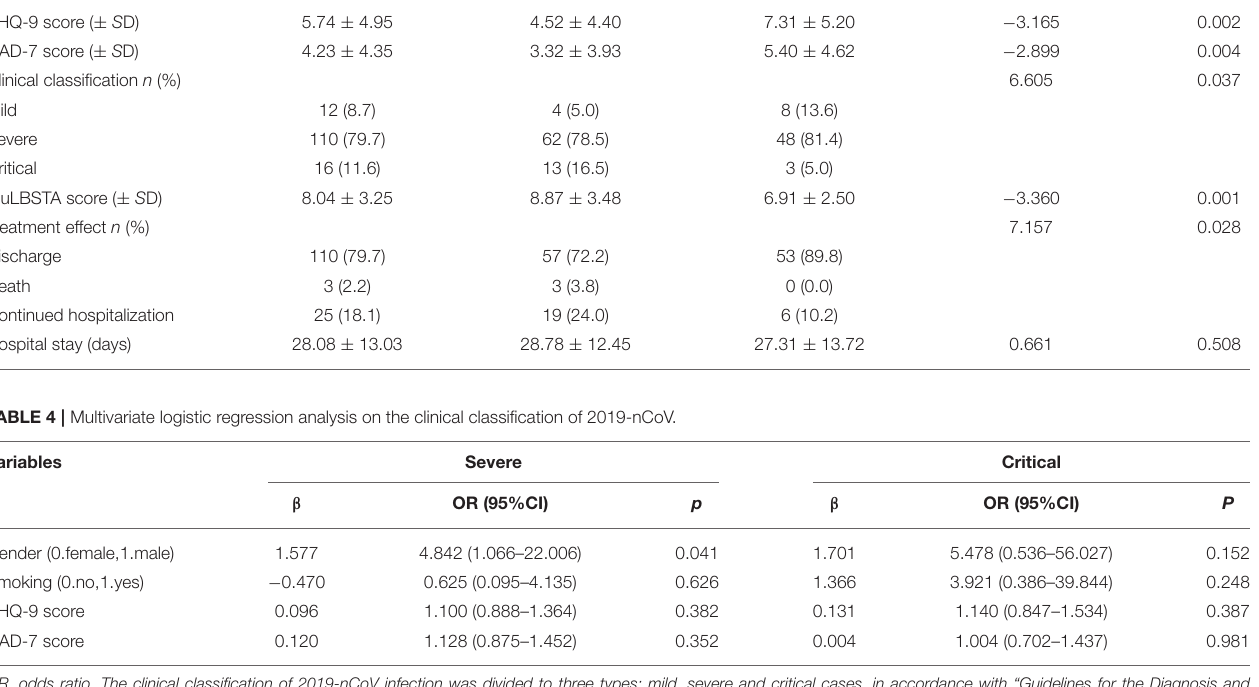
TABLE 3 | Gender differences in psychological status and clinical outcomes of 2019-nCoV infection. Variables